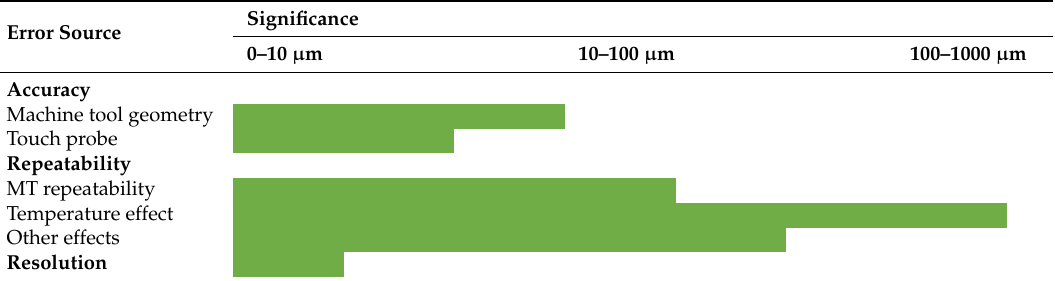
Table 3. Error budget for large size